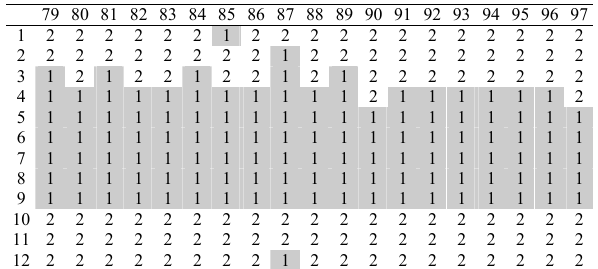
Table 1. The occurrence of types in individual months in years 1979 to 1997 (denoted by the last two digits) for 2 rotated PCs of raw data in NH. The summer type (1) is shaded for easier visualization